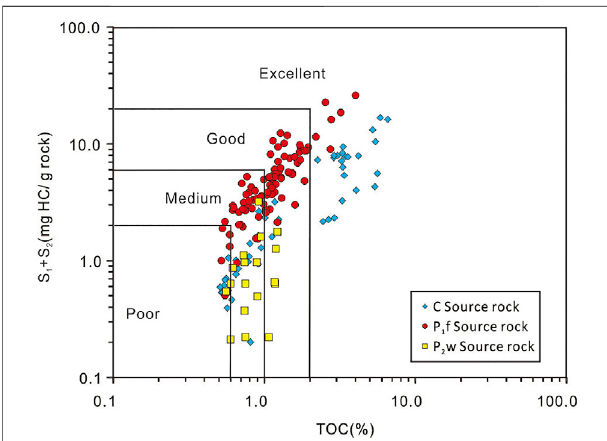
FIGURE 9 | The TOC vs. S 1 + S 2 plot of C, P 1 f, and P 2 w source rocks in the Junggar